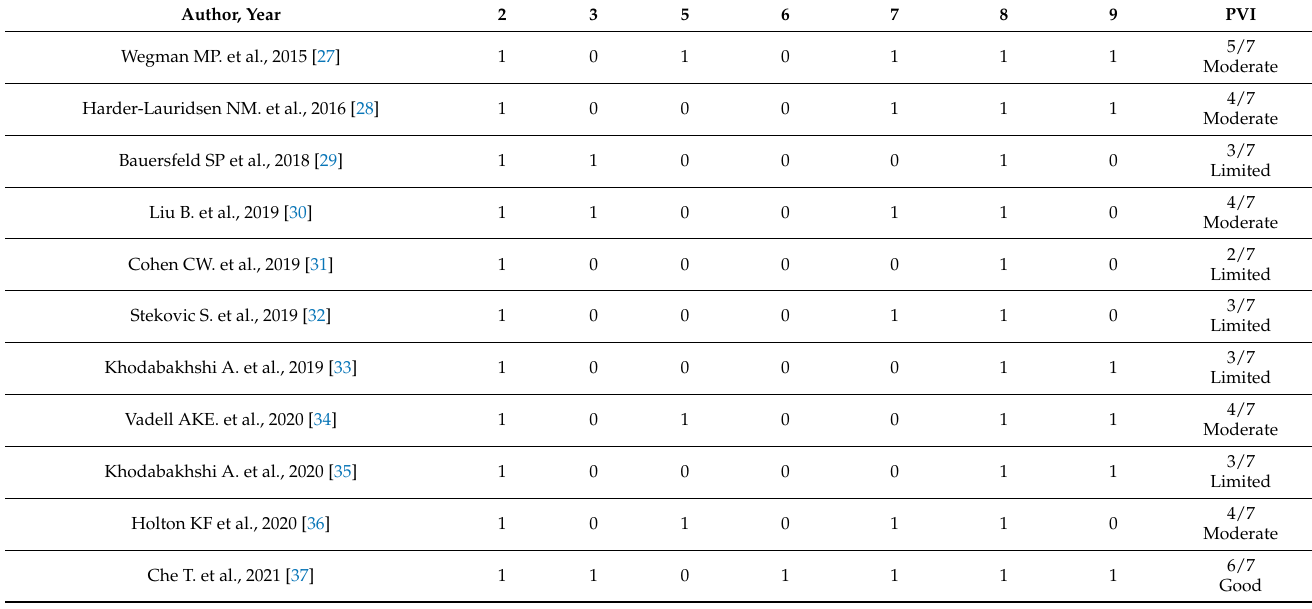
Table 3. Internal validity of the selected